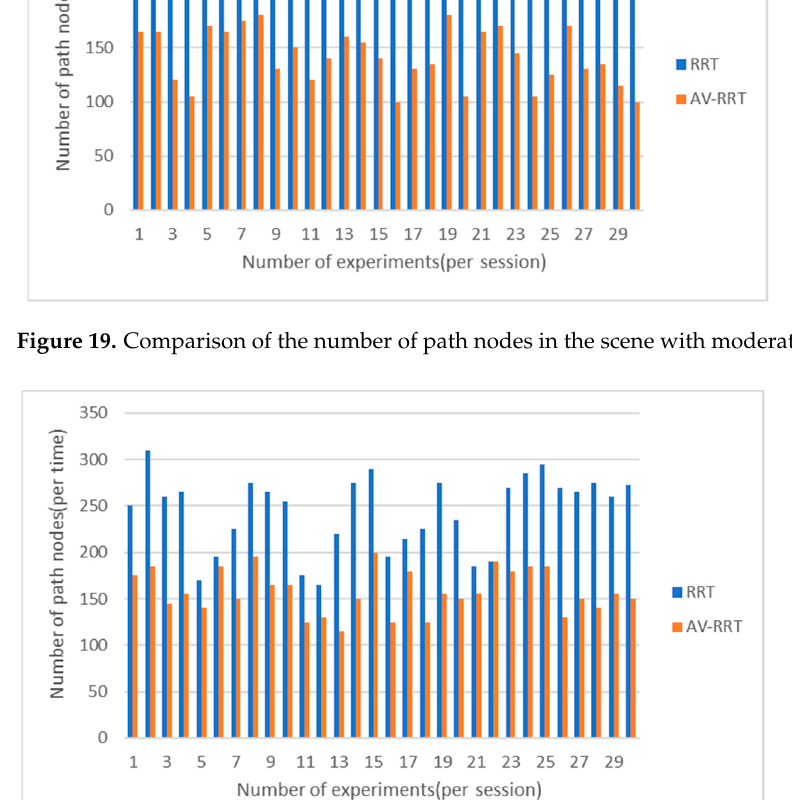
Figure 21. Comparison for number of return path nodes in each scenario with AV-RRT algorithm. (3) Comparison of Consumption of Time based on AV-RRT and based on RRT From Figures 22–25, it can be seen that in each scene, consumption of time for both the RRT algorithm and AV-RRT algorithm is greater. However, the latter algorithm is more stable than the former, and the consumption of time by the AV-RRT algorithm is shorter than RRT algorithm, especially in the scene with sparse obstacles, which is caused by the dynamic step size. Figure 22. Comparison of consumption of time in the scene with sparse obstacles.